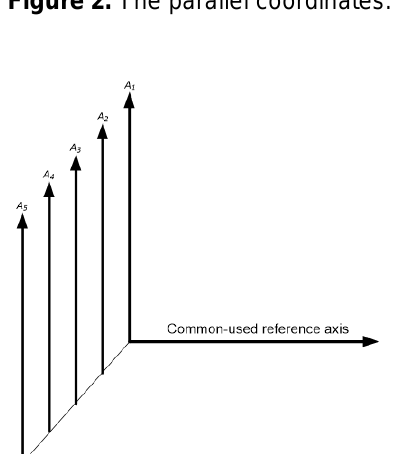
Figure 2. The parallel coordinates.